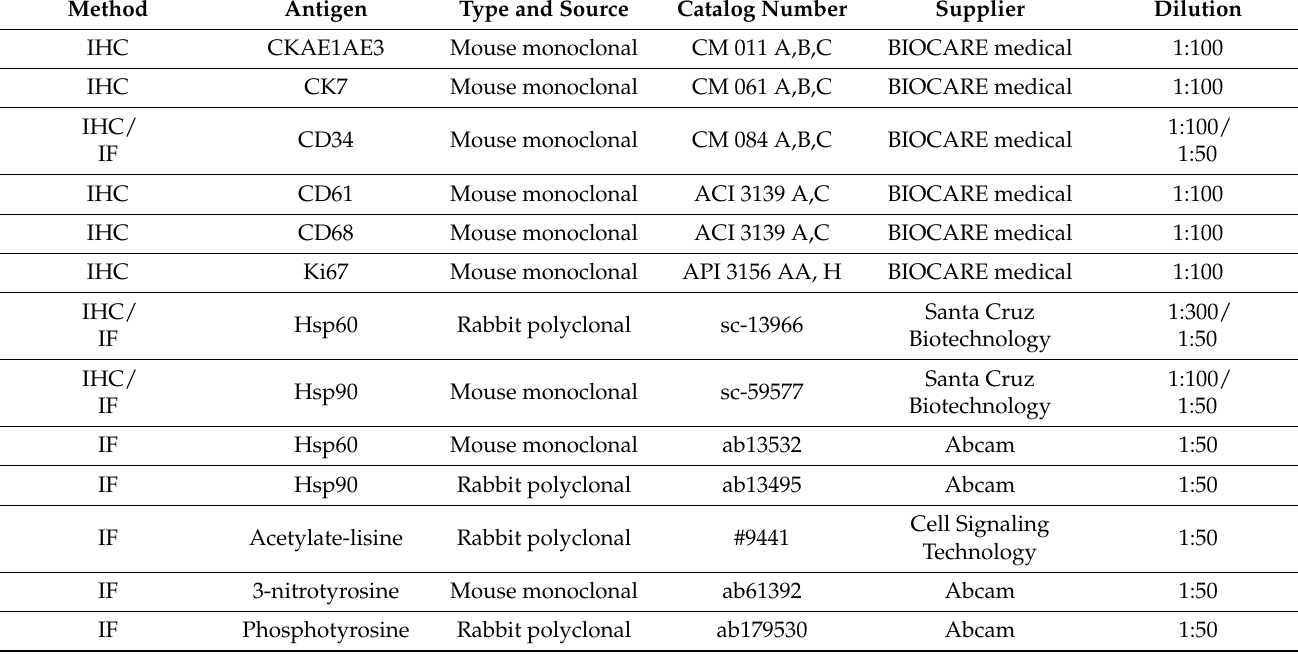
Table 2. Primary antibody used for IHC and